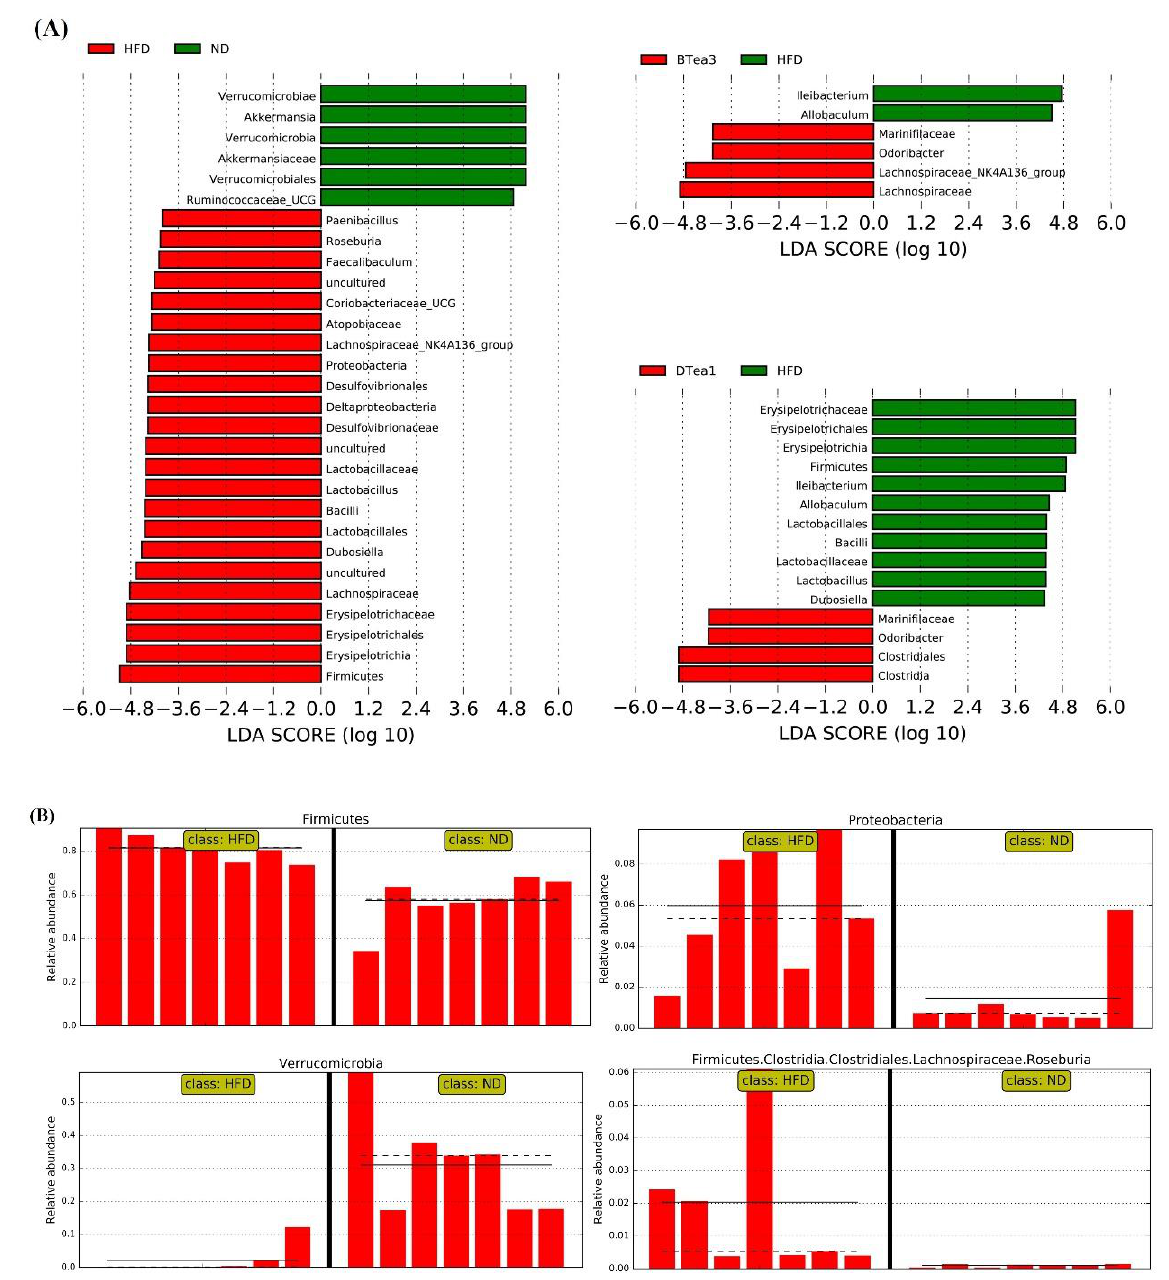
Figure 9. The key differentially abundant taxa of gut microbiota (from phylum, class, order, family to genus levels, respectively) in response to HFD in combination with different black and dark teas treatment. ( A ) LEfSe analysis showed the most divergent abundant taxa. Linear discriminant analysis (LDA) score > 4 is displayed; HFD (red) + ND (green); BTea3 (red) + HFD (green); DTea1 (red) + HFD (green). ( B ) the relative abundance of Phylum of Firmicutes , Proteobacteria and Verrucomicrobia and genus of Roseburia between ND group and HFD group from the LEfSe analysis. ND, the control group (normal diet group); HFD, the model group (high-fat diet group); BTea1, selenium-enriched black tea; BTea2, Dianhong tea; BTea3, Yingde black tea; DTea1, Fu brick tea; DTea2, Liupao tea; DTea3, selenium-enriched dark